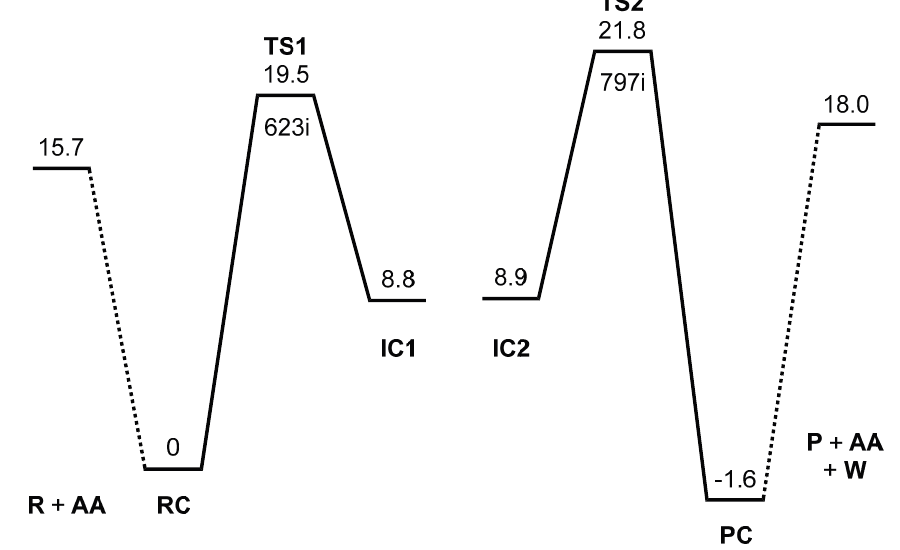
Figure 1. Energy diagram for the two-step formation of N -phthalimide from phthalanilic